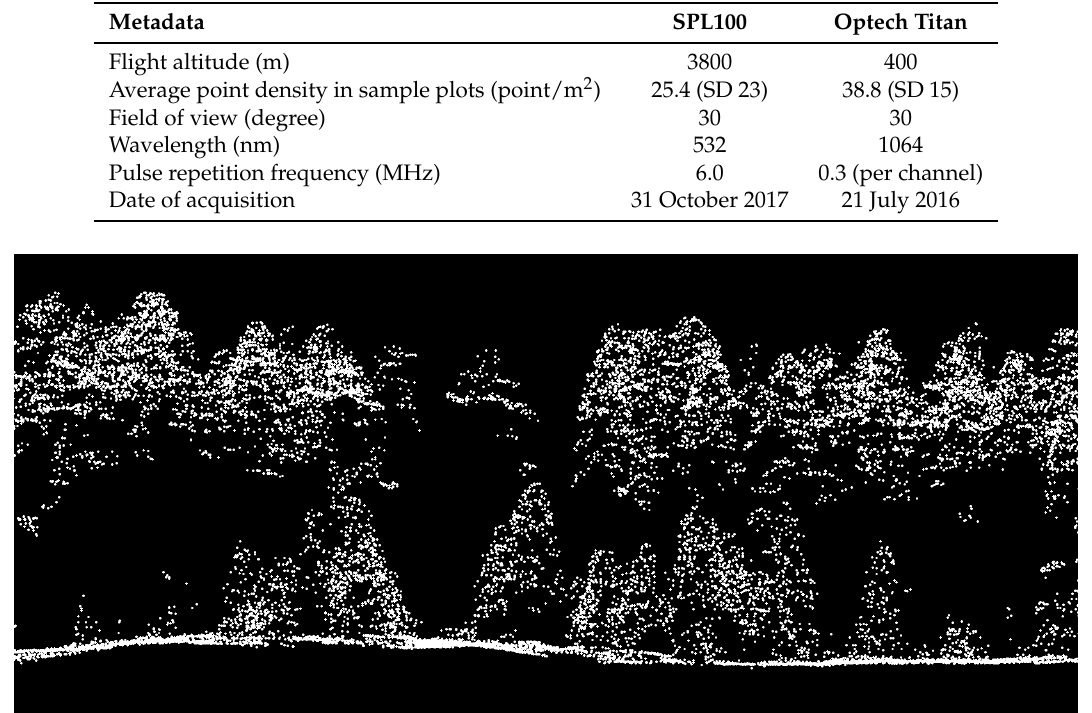
Figure 2. The image illustrates a transect of SPL100